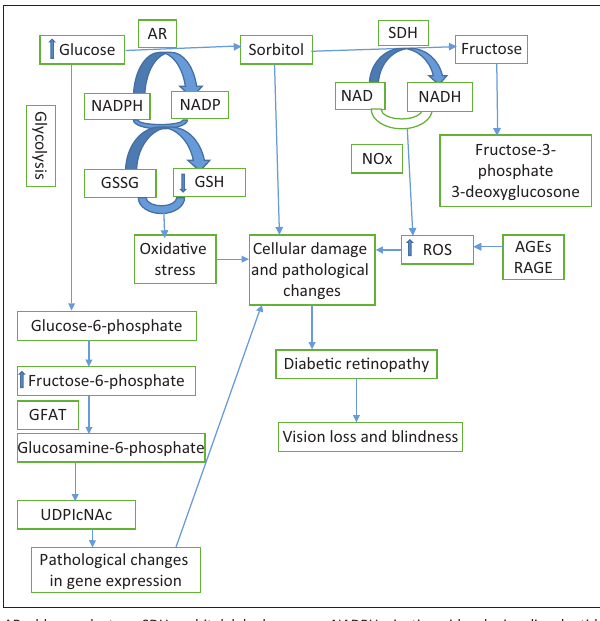
FIGURE 4: Unified biochemical mechanisms of diabetic complication in the retina. The polyol pathway is started by the conversion of glucose to sorbitol, and the further reduction of sorbitol into fructose by aldose reductase and sorbitol dehydrogenase enzymes, respectively. All of these pathways lead to increased oxidative stress, inflammation and vascular dysfunction. Oxidative stress and inflammation result in upregulation of growth factors which contribute to breakdown of the blood–retinal barrier and development of diabetic macular